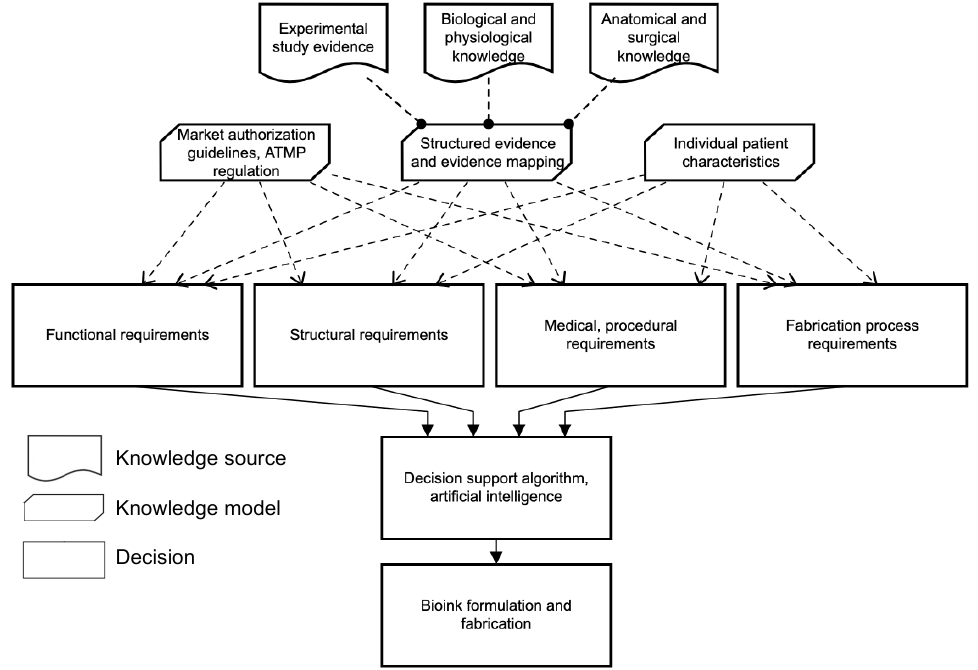
Figure 6. Decision model for bioink development. Evidence-driven or rather structured data-driven decision model and translation to an end-to-end process by decision model notation (DMN) for development of bioink for vascularization.